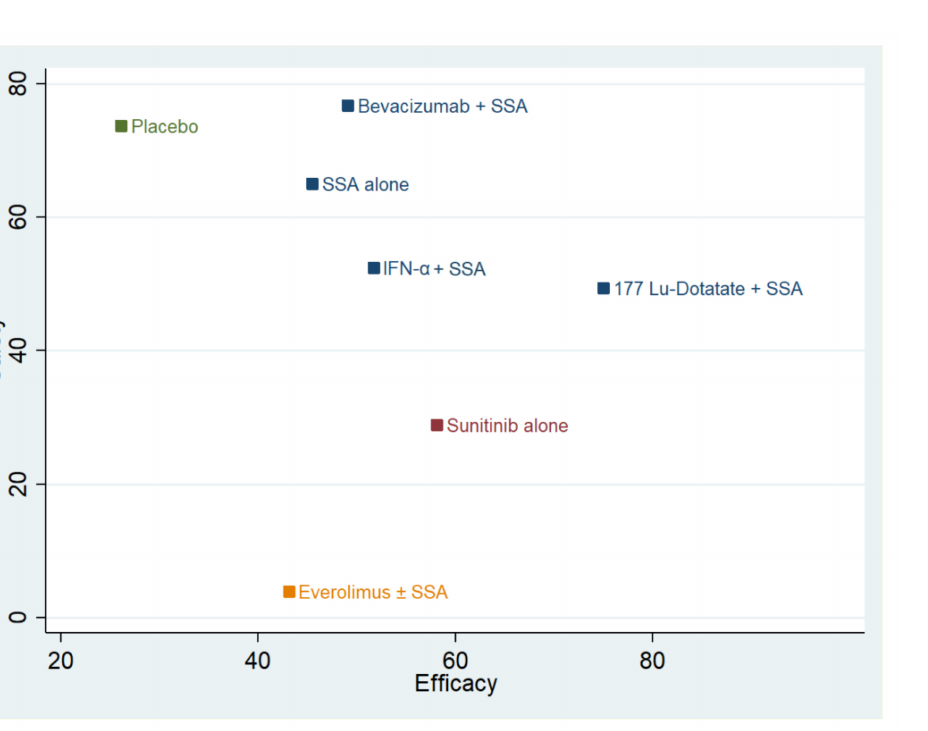
Figure 2. Cluster rank combining surface under the cumulative ranking curve (SUCRA) values. The y -axis reports the SU- CRA values as a percentage of “safety” (toxicity 3 and 4). The x -axis reports the efficacy (progression-free survival). Different colors identify the different clusters. SSA = somatostatin analog ; 177 -Lu-Dotatate = Lutezio with Dotatate; IFN- α = interferon